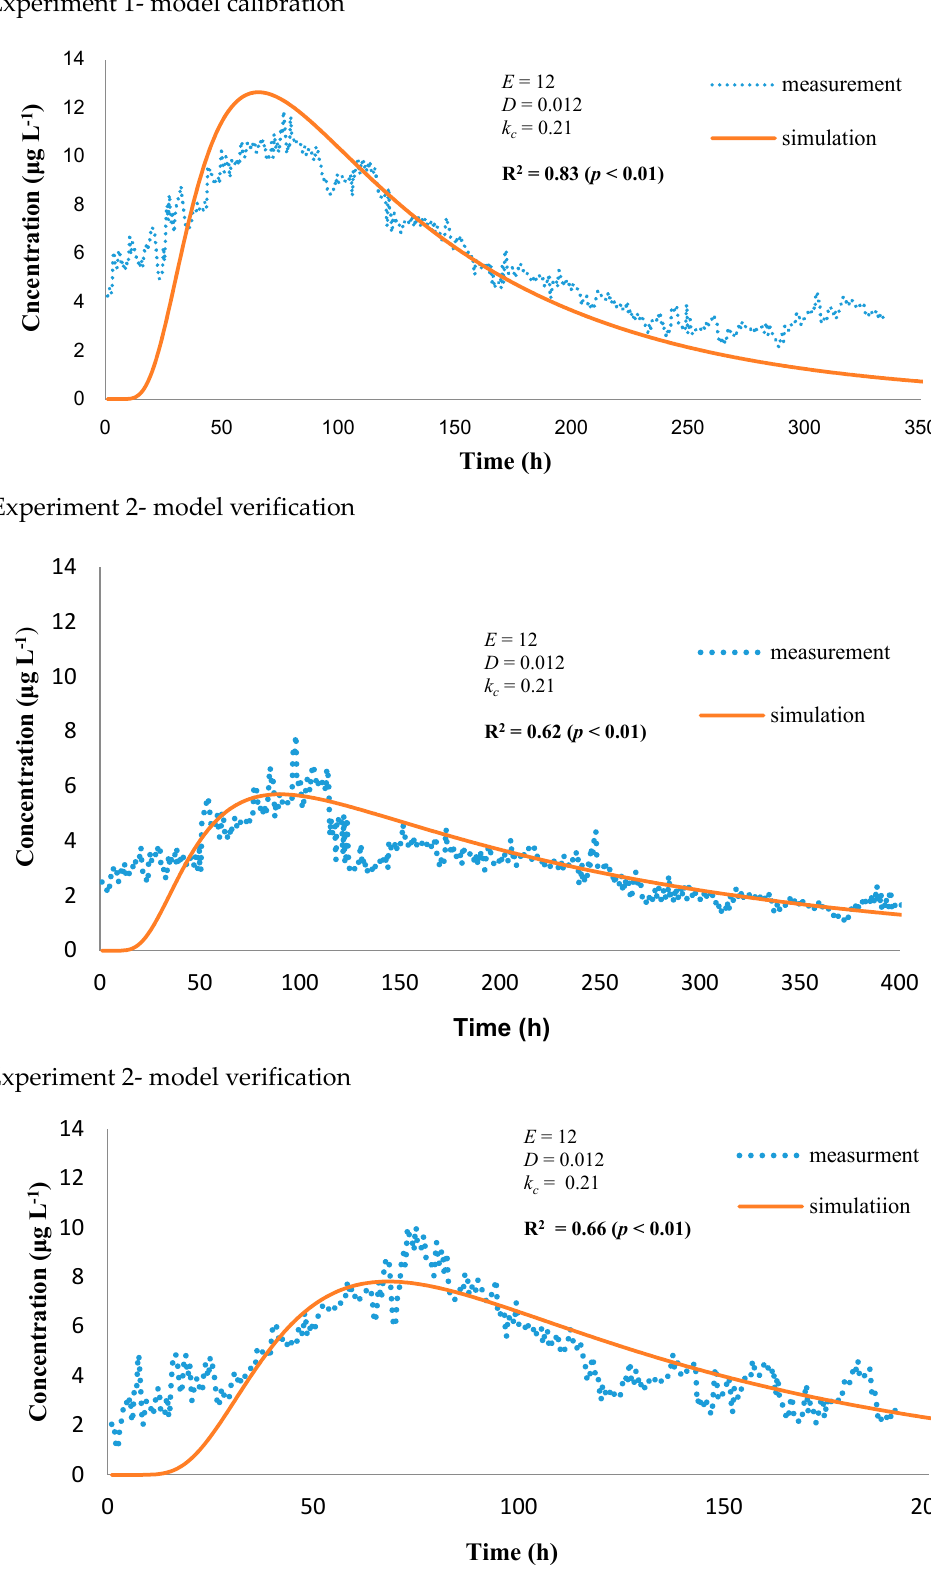
Figure 2. Results of mathematical model validation: ( a ) measurements from Exp. 1 for model calibration; ( b ) measurements from Exp. 2 for the first verification; and ( c ) measurements from Exp. 3 for the second verification. The correlation coefficients (R 2 ) were 0.83, 0.62, and 0.66. The eddy viscosity ( E ), dispersion coefficient ( D ), and decay coefficient ( K c ) were determined to be 12, 0.012, and 0.21, respectively.